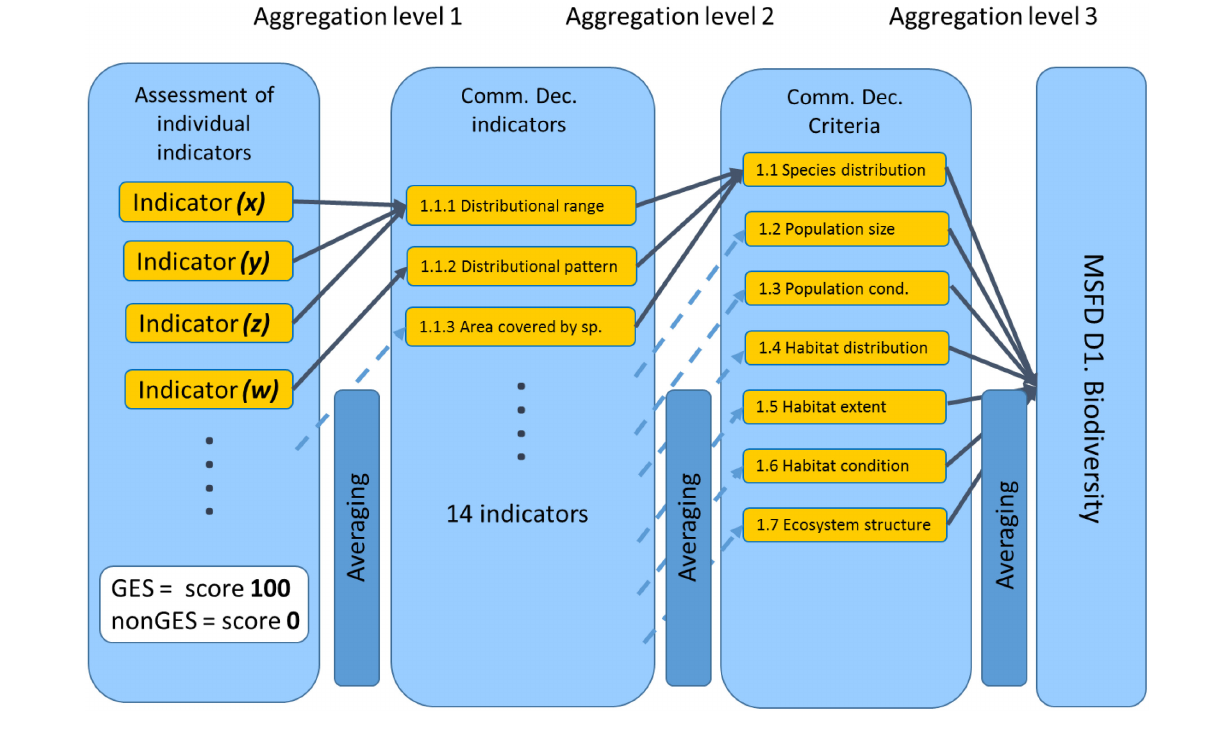
FIGURE 6 | MARMONI hierarchical approach for aggregation of assessment scores from individual indicators, through different levels used in Commission Decision document (European Commission, 2010). GES, Good Environmental Status; MSFD, Marine Strategy Framework Directive; D1, Descriptor